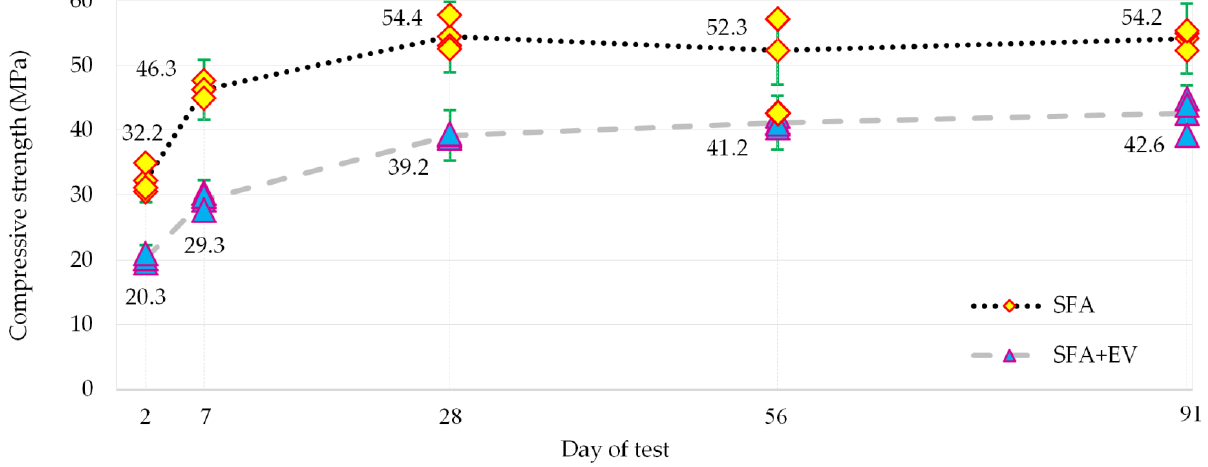
Figure 8. Compressive strength .